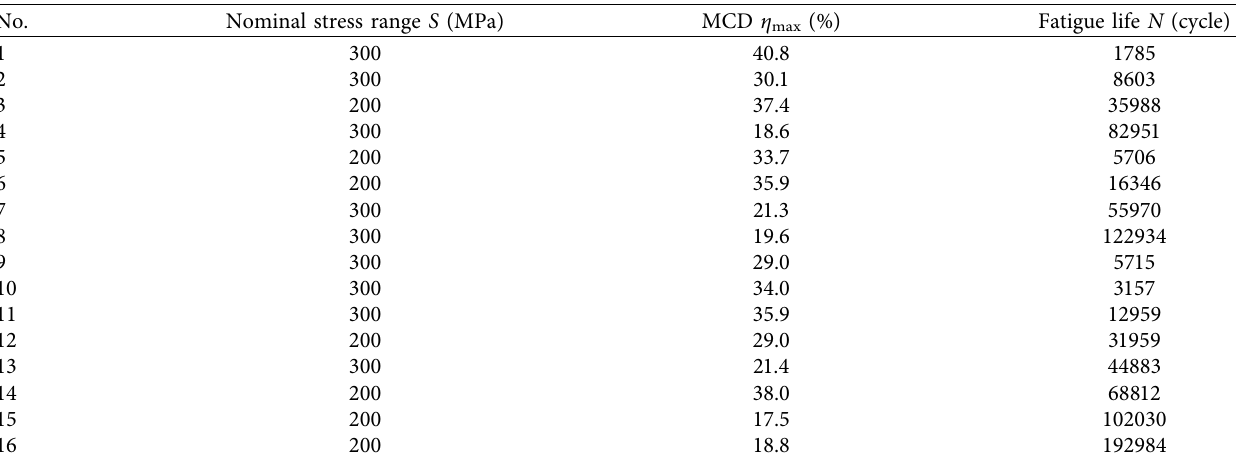
Table 5: Testing results (10mm-diameter bars) arbitrarily chosen from [13], representing observed data for Bayesian updating.